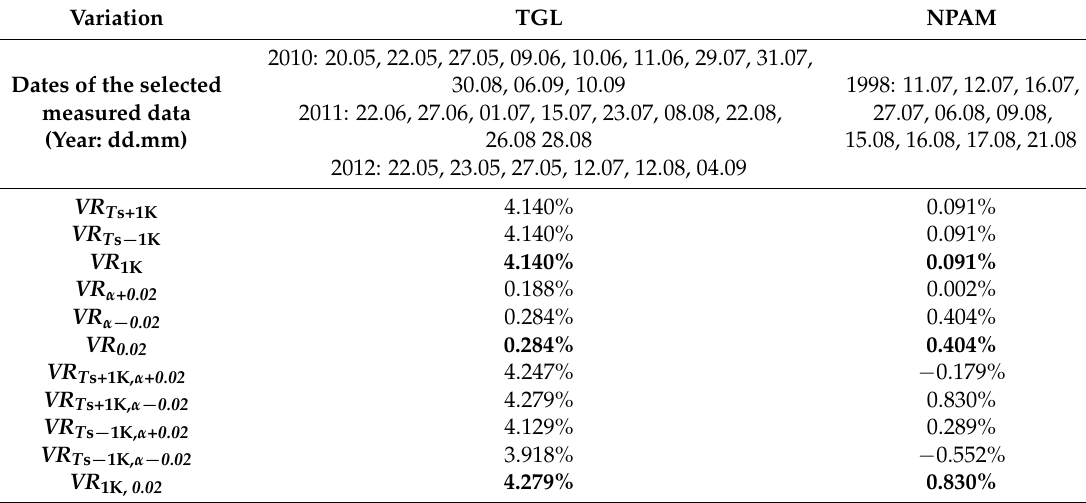
Table 8. Average sensitivity of the G 0 parameterization scheme Ma impr to land surface temperature T s and land surface albedo α .